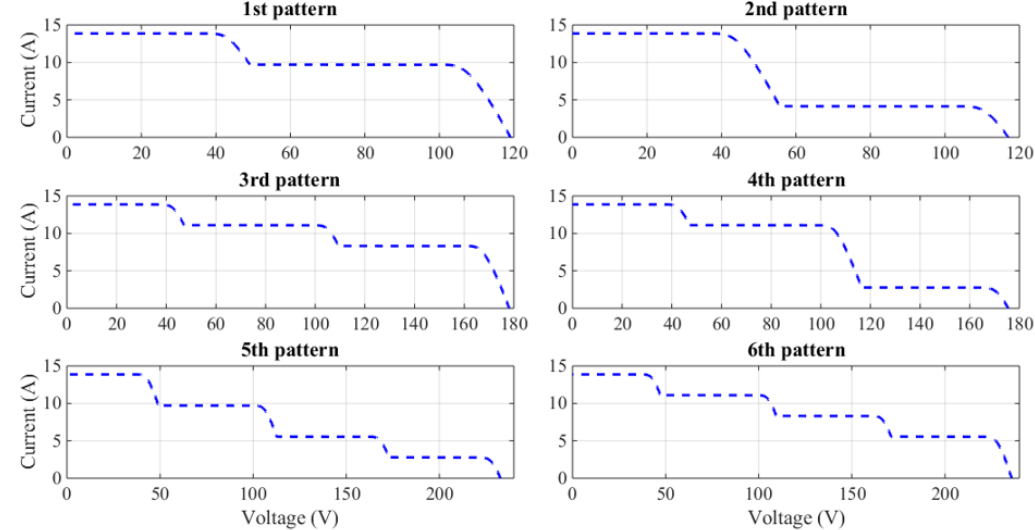
Figure 5. The current-voltage (I–V) curves of the studied PV systems with different shadow patterns.